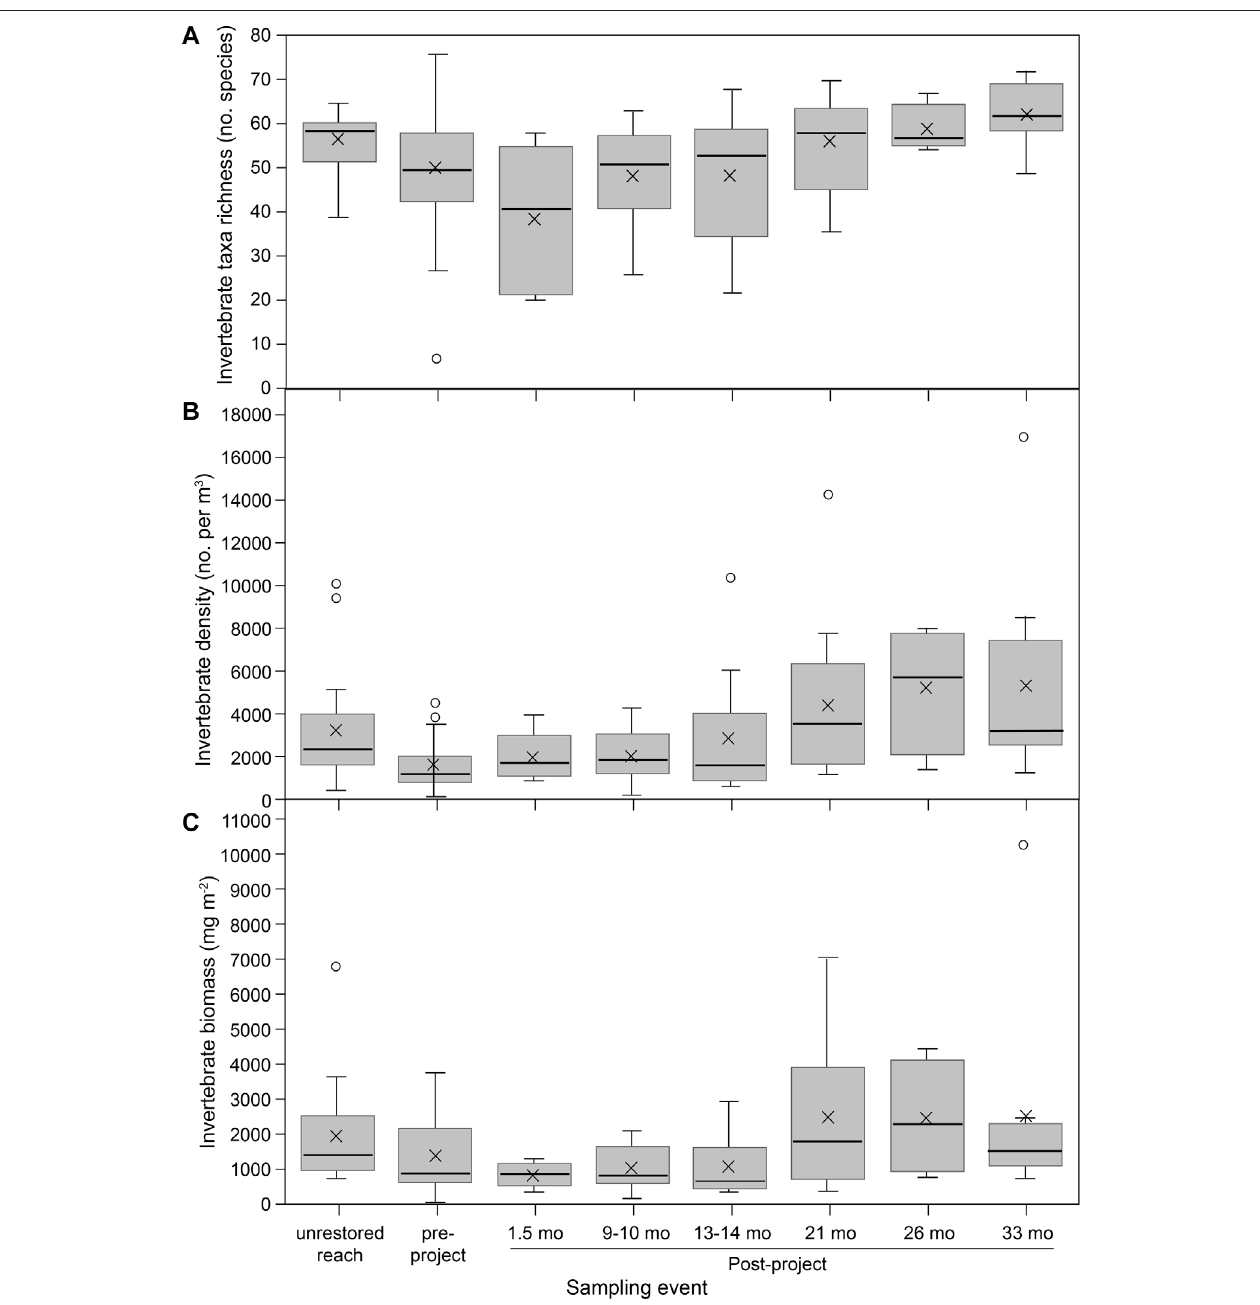
FIGURE 8 | South Fork McKenzie River benthic macroinvertebrates from reference (unrestored) habitats, pre-restoration, and in the months post-restoration for: (A) invertebrate taxa richness; (B) invertebrate density; and (C) invertebrate biomass. Boxplot center line is the median, and X is the data mean.